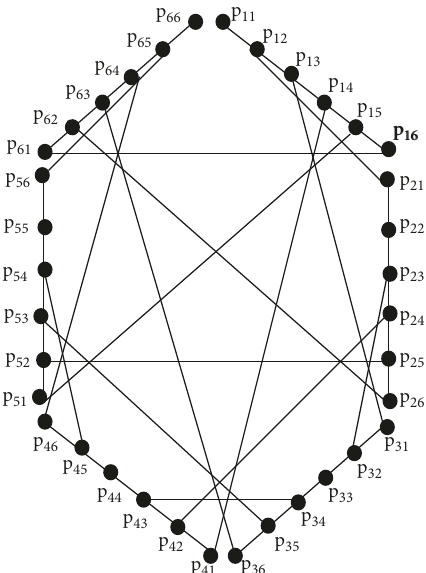
Figure 1: Graph of swapped OTIS OP